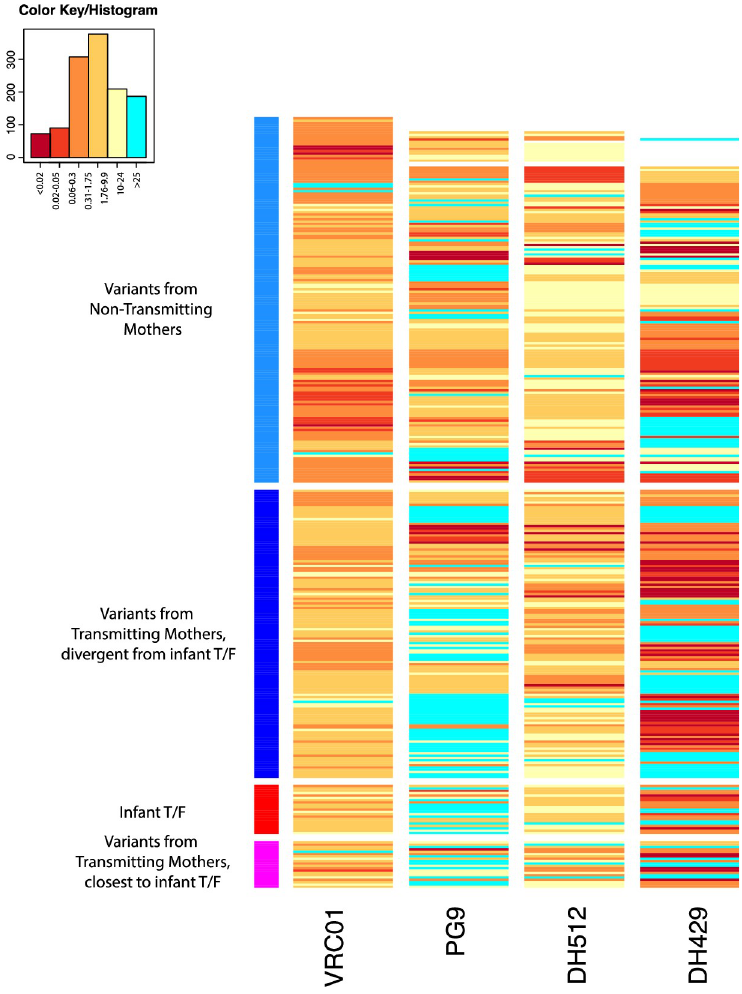
Fig 4. Neutralization sensitivity of infant and maternal Env variants against a panel of bnAbs. Heatmap of bnAbs VRC01, PG9, DH512 and DH429 IC50 against non-transmitting, transmitting, and infant T/F variants, generated using the Heatmap tool on the Los Alamos HIV Database. Rows represent viruses and columns represent bnAbs. The darker hues indicate more potent neutralization, and aquamarine indicates IC50s above threshold, unable to reach this level of neutralization at the highest concentration of bnAb tested. Top rows (indicated by the light blue column to the left) are the variants from the non-transmitting mothers, below (dark blue on the left) are the non-transmitted variants from transmitting mothers, followed by infant T/Fs (red) and transmitting mother variants closest to the infant T/Fs (magenta, bottom).